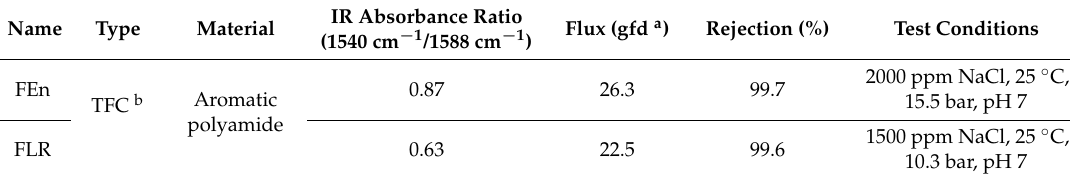
Table 2. Details of the reverse osmosis membranes used in the